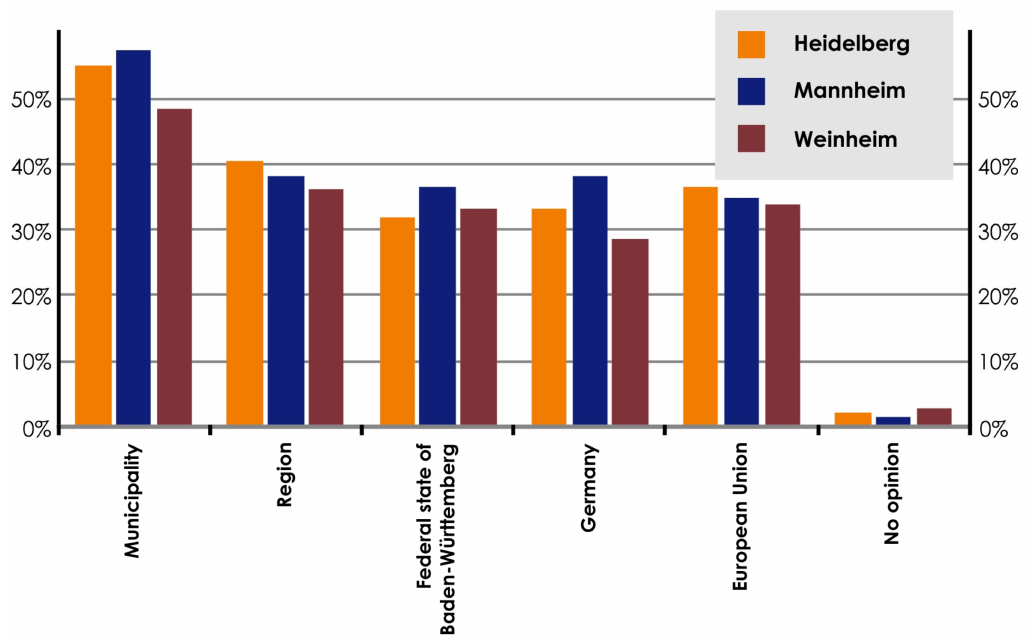
Figure 2. In your opinion, who should decide and implement climate protection measures in the area of planning and administration? Own illustration, based on household surveys, Heidelberg (n = 128), Mannheim (n = 127), and Weinheim (n =